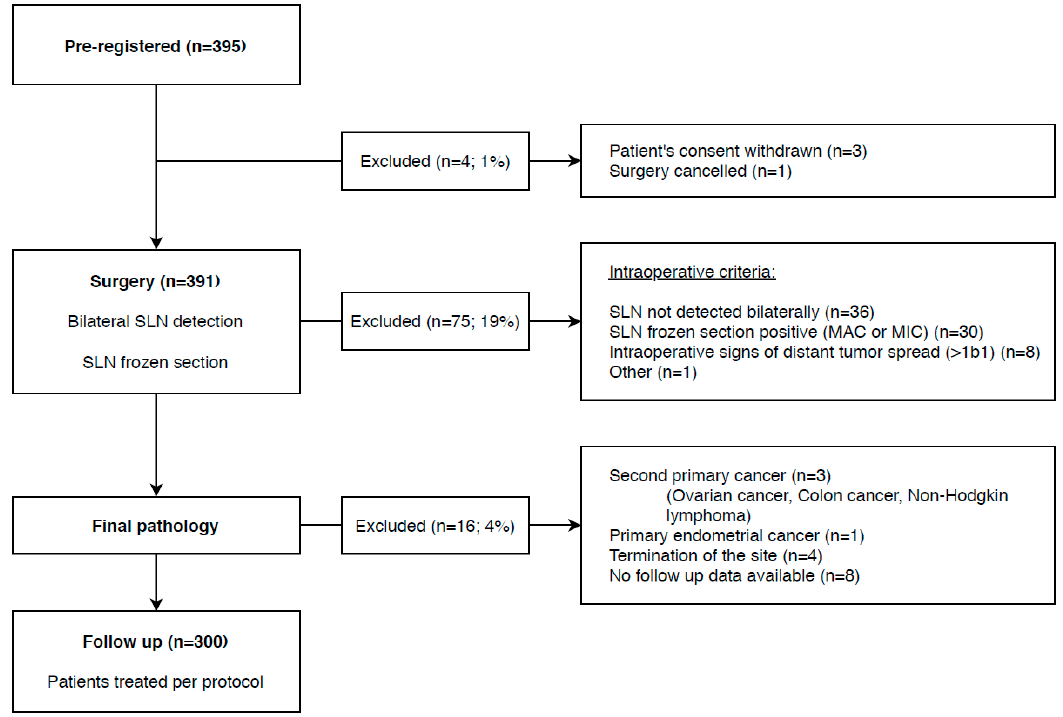
Figure 2. Flow chart for patients registered into the SENTIX trial.